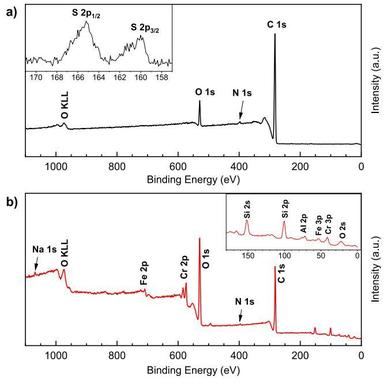
XPS survey scans of a) DND and b) ODND.